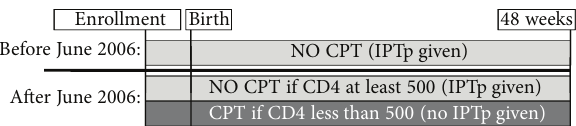
Figure1:IntheBANStudy,womenwereenrolledduringpregnancy and followed until 48 weeks postpartum. Prior to June 2006, all women received SP-IPTp as recommended by the Malawi Depart- ment of Health. Following WHO recommendations, after June 2006 CPT was implemented for women with a CD4 of less than 500 and SP-IPTp was discontinued for these women. Women with a CD4 of 500 or greater continued to receive